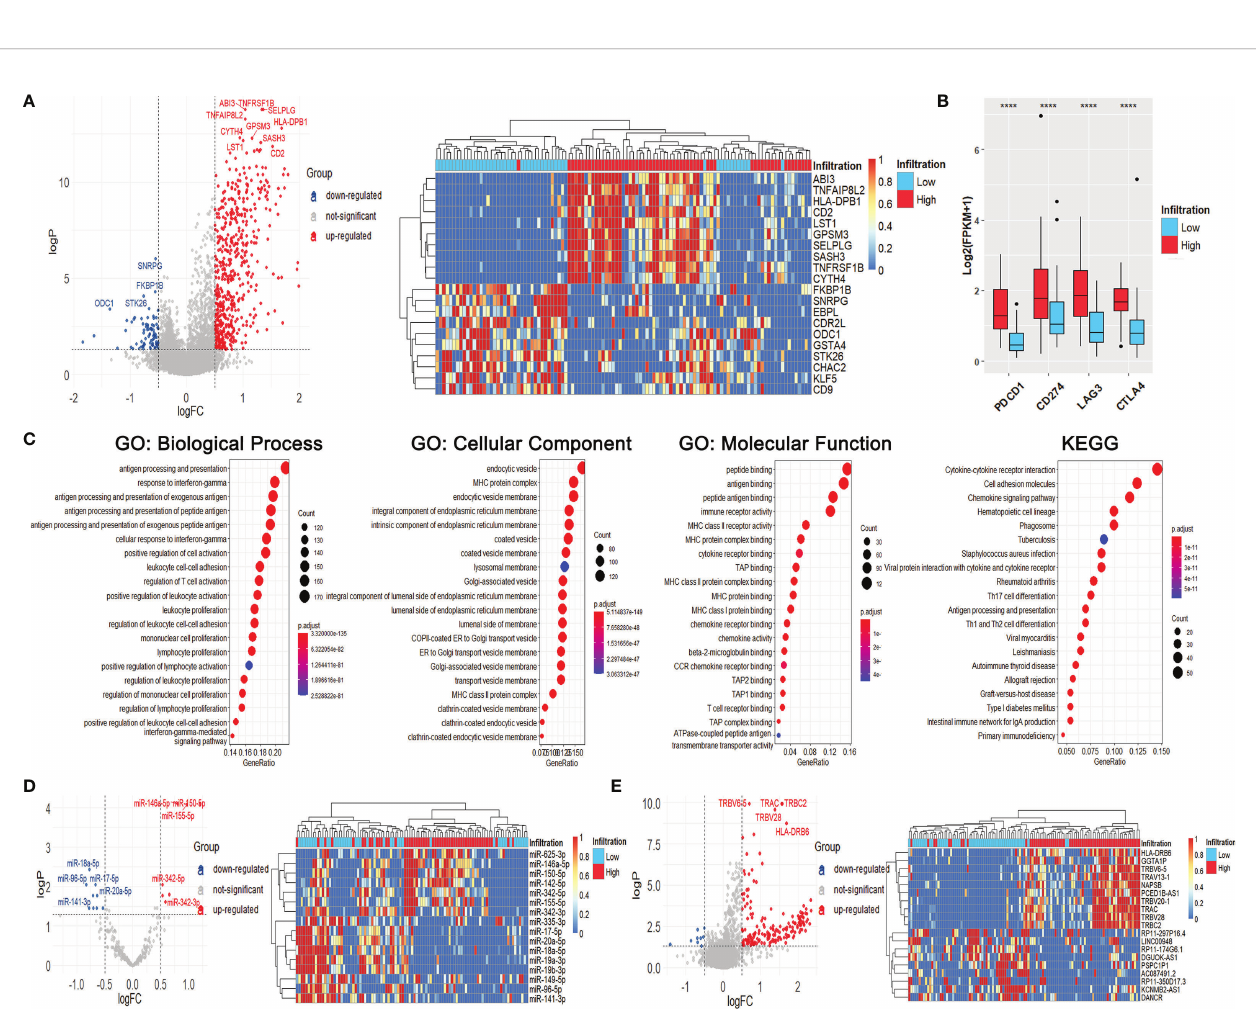
FIGURE 3 | Immune in fi ltration status, differentially expressed genes, miRNAs, and lncRNAs of LSCC patients with different immune-in fi ltration phenotypes in the TCGA cohort. (A) Volcano plot and heatmap of DEGs. (B) Expression of common targets of immune therapies. ****p < 0.0001. (C) GO and KEGG analyses of DEGs. (D) Volcano plot and heatmap of differentially expressed miRNAs. (E) Volcano plot and heatmap of differentially expressed